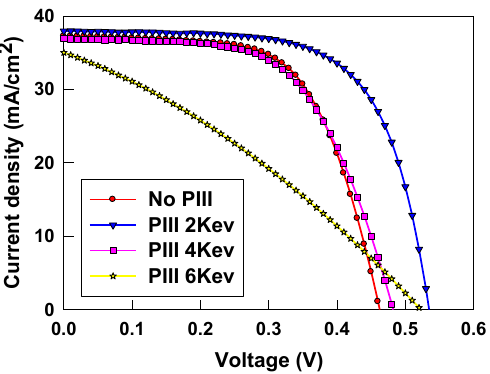
Figure 6. The I-V characteristic curve of without PIII, PIII 2 Kev, PIII 4 Kev, and PIII 6 Kev homojunction samples.